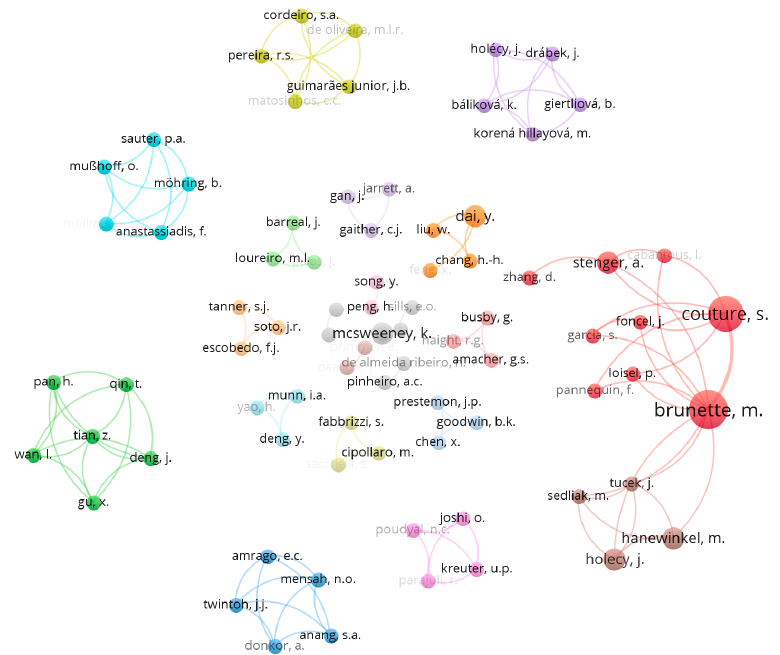
Figure 2. The networks of the authors and co-citations, created with VOSViewer.